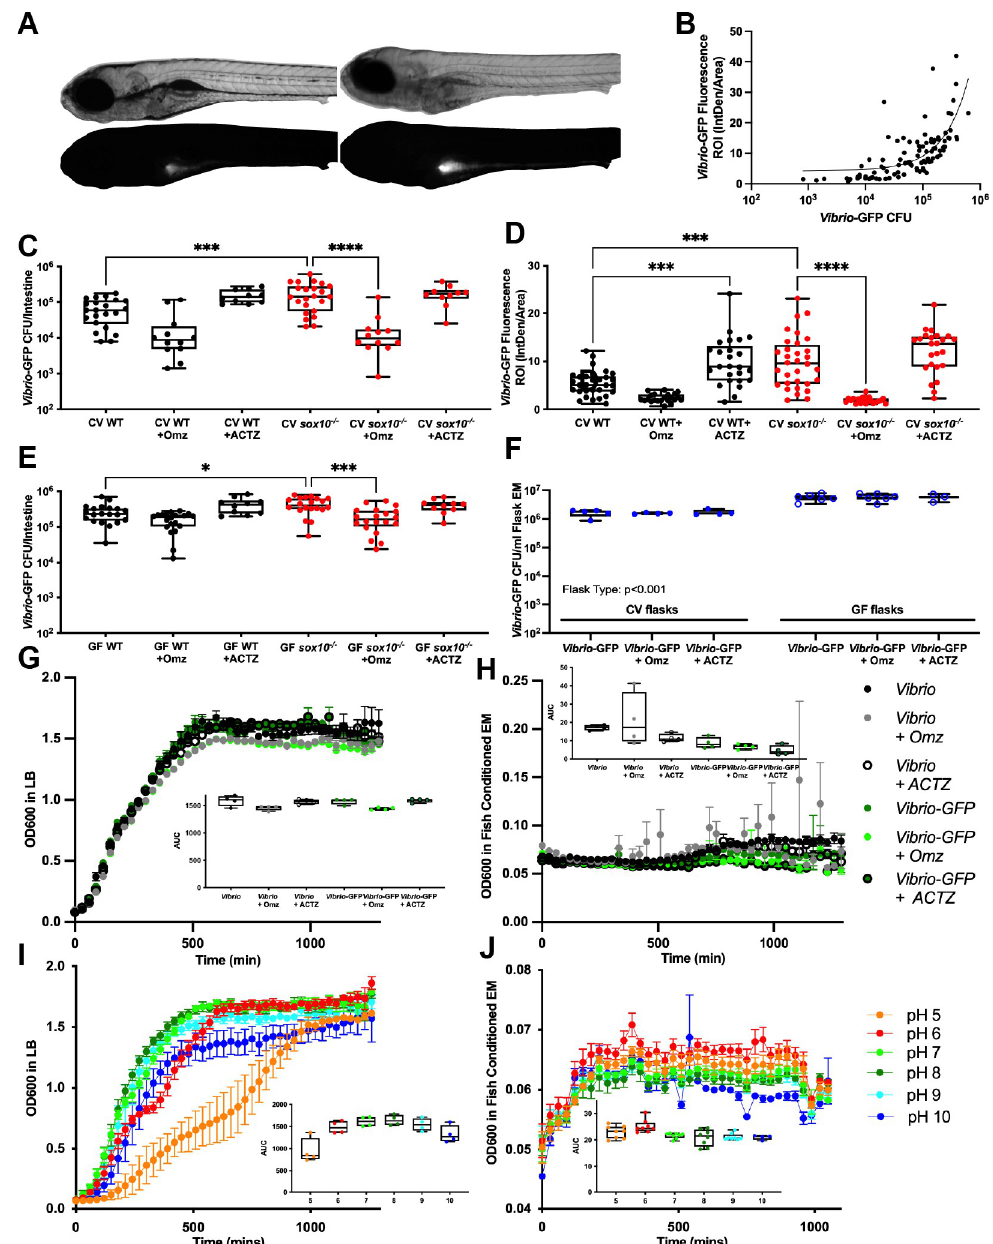
Fig 6. Luminal pH regulates Vibrio abundance. (A) Representative images of bright field (top) and fluorescence (bottom) showing WT (left) and sox10 -/- (right) larvae after 24 hour exposure to Vibrio -GFP. (B) Fluorescence intensity of intestinal lumen correlates with abundance of Vibrio -GFP Colony Forming Units/intestine (CFU/intestine). (C) Quantification of Vibrio -GFP colonization level (CFU/intestine) in CV WT and sox10 mutants after 24 hour exposure to Vibrio -GFP and 200 μ M Omz or ACTZ (CV WT vs CV WT+OMZ t-test p = 0.01; CV WT vs CV WT + ACTZ: t-test p = 0.003). (D) Quantification of Vibrio -GFP luminal fluorescent intensity in CV WT and sox10 mutants after 24 hour exposure to Vibrio - GFP and 200 μ M Omz or ACTZ (CV WT vs CV WT+OMZ t-test p = < 0.0001). (E) Quantification of Vibrio -GFP colonization level (CFU/intestine) in GF WT and sox10 mutants after 24 hour exposure to Vibrio -GFP and 200 μ M Omz or ACTZ (CV WT vs CV WT+OMZ t-test p = 0.01; CV WT vs CV WT + ACTZ: t-test p = 0.003). (F) Quantification of Vibrio -GFP colonization level (CFU/mL) in CV and GF flask embryo media (EM) after 24 hour exposure to 200 μ M Omz or ACTZ. (G-H) Vibrio and Vibrio -GFP growth curves and area under the curve (AUC) in LB (G) and fish conditioned EM (H) with 200 μ M Omz or ACTZ. (I-J) Vibrio growth curves and AUC in controlled pH LB (I) and fish conditioned EM (J). Each dot is a fish; n > 12 for each condition (B-E), each dot is a flask (F), each dot is an average absorbance of 4 experimental replicates of at least 2 individual experiments (G&H). Boxes represent the first to third quartiles, center bar